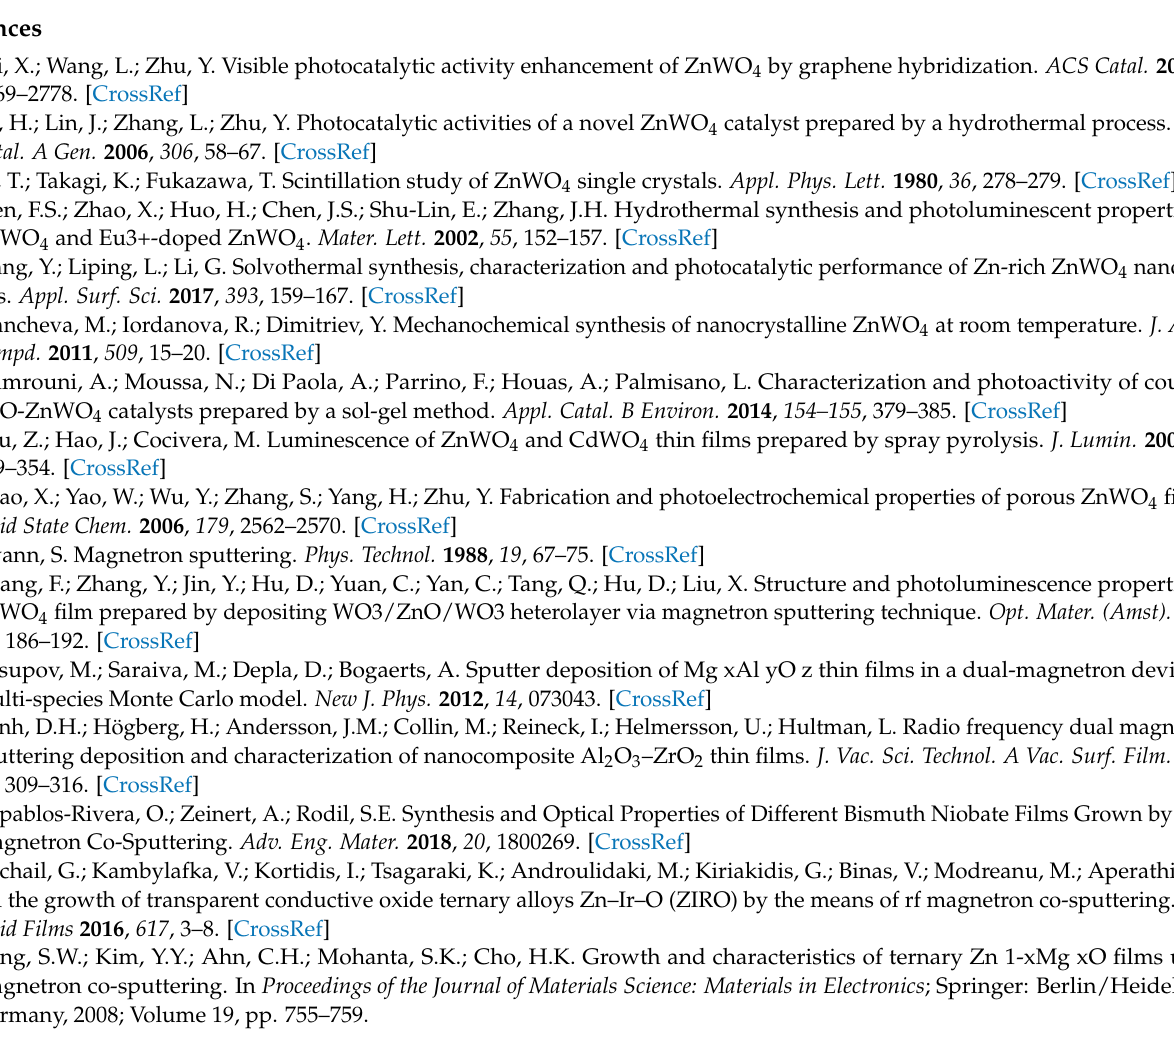
Figure S7: Survey, Zn 2p 3/2 , O 1s and W 4f core level, and valence band (VB) XP spectra of a 15 nm thick amorphous ZnWO 4 film; Figure S8: SEM image of 100 nm monoclinic ZnWO 4 thin films annealed in air at 600 ◦ C for 10 h; Figure S9: SEM-EDS of 100 nm monoclinic ZnWO 4